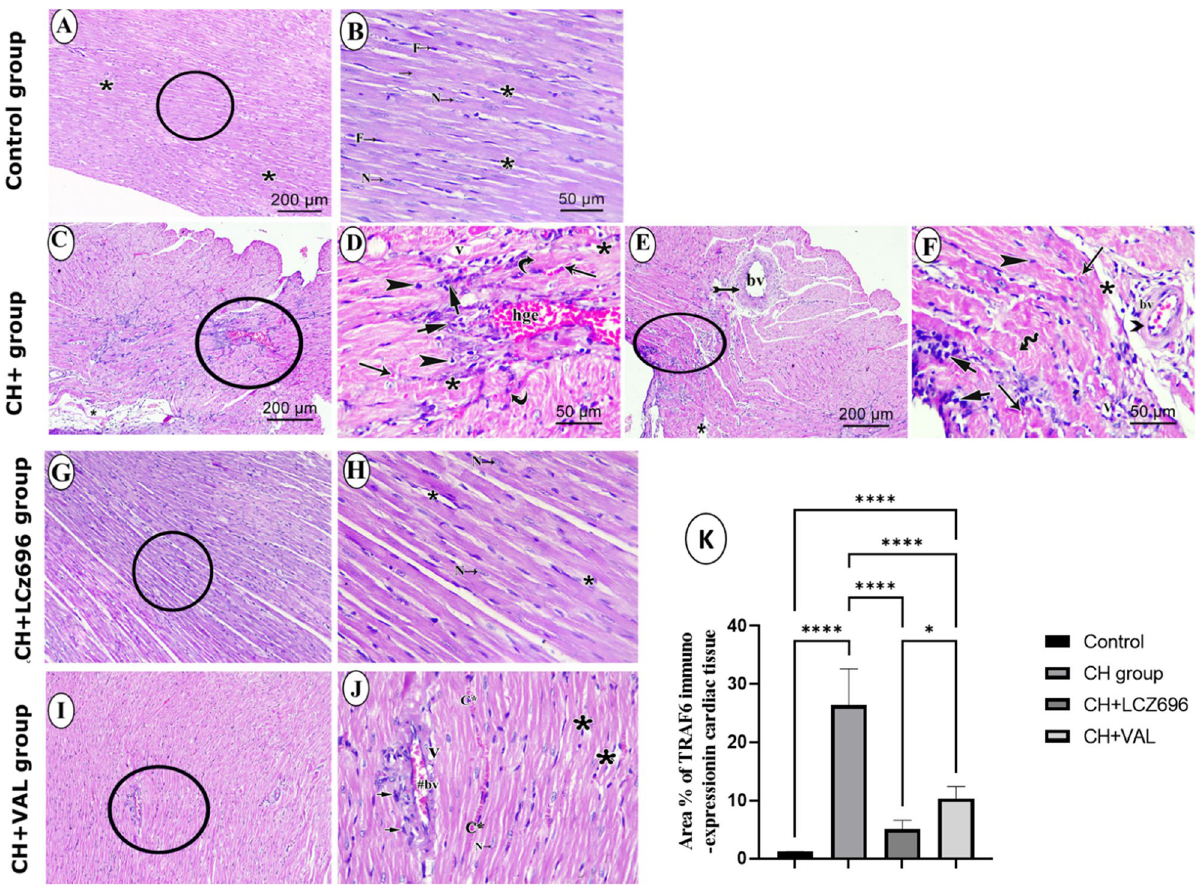
Figure 5. Microscopic images of H&E stain of cardiac muscle of left ventricle from different experimental groups. Control group ( A , B ): ( A ) shows normal myocardial architecture as branching and anatomizing muscle fibers with narrow interstitial spaces (*) and without inflammatory infiltrate or congestion. ( B ) Higher power of encircled area of ( A ) shows cardiomyocytes with acidophilic sarcoplasm, central oval vesicular nucleus (N), narrow interstitial spaces (*), and nucleus of interstitial fibroblast (F). CH group ( C – F ): ( C ) shows disturbed normal architecture of myocardial fibers and widening of interstitial spaces (*). ( D ) The higher power of encircled area of ( C ) shows abundant cellular infiltration (short arrow), pyknotic nuclei (arrowhead), areas of interstitial hemorrhage (hge), extravasated red blood cells (long arrow), wide interstitial spaces (*), dark acidophilic sarcoplasm (curved arrow) and areas of vacuolation (v). ( E ) another image of the CH group shows disturbed normal architecture of myocardial fibers, thickened wall (bifid arrow) of the blood vessel (bv), and widening of interstitial spaces (*). ( F ) Higher power of encircled area of ( E ) shows wavy myocardial fibers (wavy arrow), thickened wall of the blood vessel ( > ), abundant cellular infiltration (short arrow), extravasated red blood cells (long arrow), wide interstitial spaces (*) and areas of vacuolation (v). CH + LCZ696 group ( G , H ): (G) shows normal branching and anastomosing myocardial fibers separated by slightly interstitial space. (H) Higher power of encircled area of ( G ) group reveals myocardial fibers with central and vesicular nuclei almost like the control group. CH + VAL group ( I , J ): ( I ) reveals normal branching and anastomosing myocardial fibers, congested blood vessel (#bv) and mild spacing between myocardial fibers (*). (J) Higher power of encircled area of ( I ) shows, congested blood vessel (#bv) surrounded by cellular infiltrations (arrow), wide interstitial space (*), small vacuoles (v), congested capillaries (c*), and normal myocardial fibers with normal vesicular nuclei (N). Scale bar: ( A , C , E , G , I ) 200 μm × 100; ( B , D , F , H , J ) 50 μm × 400. K. thickness of the left ventricle wall of the different experimental groups. Values are the mean of 6 rats per group ± S.E.M. Group means were compared by one-way analysis of variance (ANOVA) followed by Tukey post hoc tests for multiple